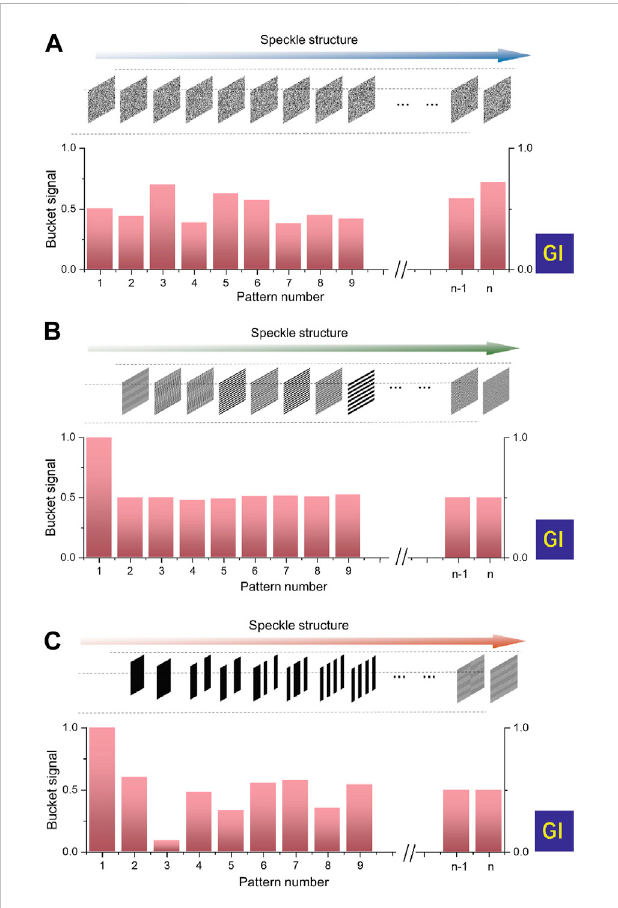
FIGURE 1 Speckle distribution of each sheet and corresponding bucket detector for ghost imaging using different patterns. (A) Random, (B) Hadamard, and (C) Walsh speckle